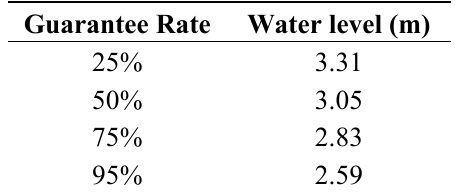
Table 1. Water level in different guarantee